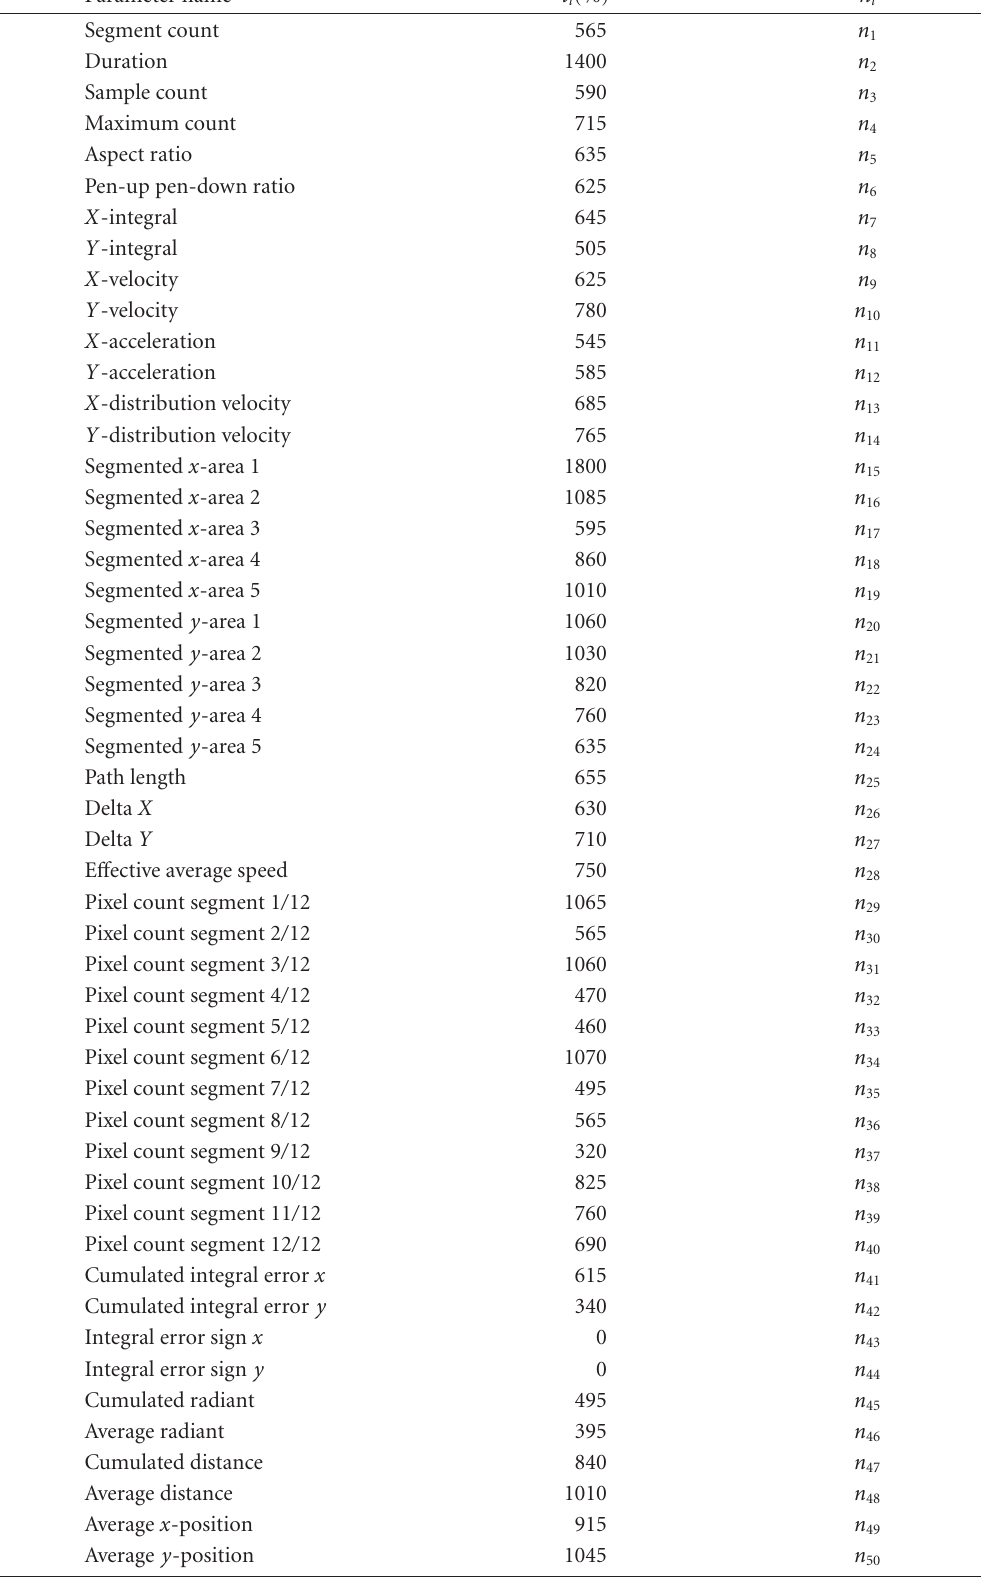
Table 2: Tolerance values estimation for N =